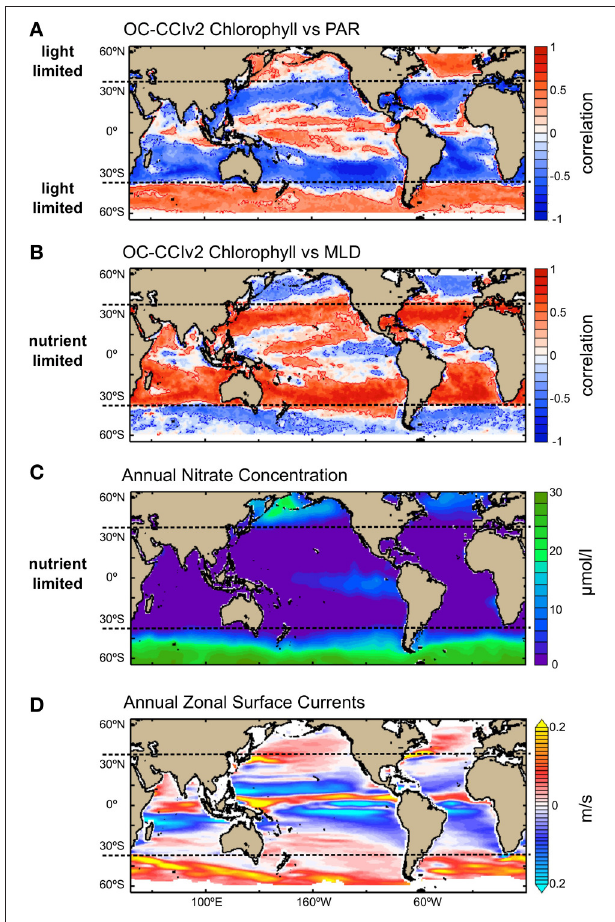
FIGURE 3 | Major factors influencing phytoplankton growth. (A) Correlation map between monthly surface chlorophyll concentration from OC-CCIv2 and photosynthetically active radiation (PAR) over the period Sep. 1997 to Dec. 2012; (B) Correlation map between monthly surface chlorophyll concentration from OC-CCIv2 and mixed layer depth (MLD) estimated using SODA vertical profiles of temperature over the period Sep. 1997 to Dec. 2008; (C) Annual average surface concentration of nitrate ( µ mol/l) from World Ocean Atlas Climatology; and (D) Annual average zonal surface currents (m/s) from OSCAR NOAA. (A,B) Positive correlation is indicated in red color and negative correlation in blue color. Contour lines indicate correlation coefficients that are significant at the 90% confidence level based on Pearson correlation coefficients. (D) Positive values indicate eastward currents and negative values westward